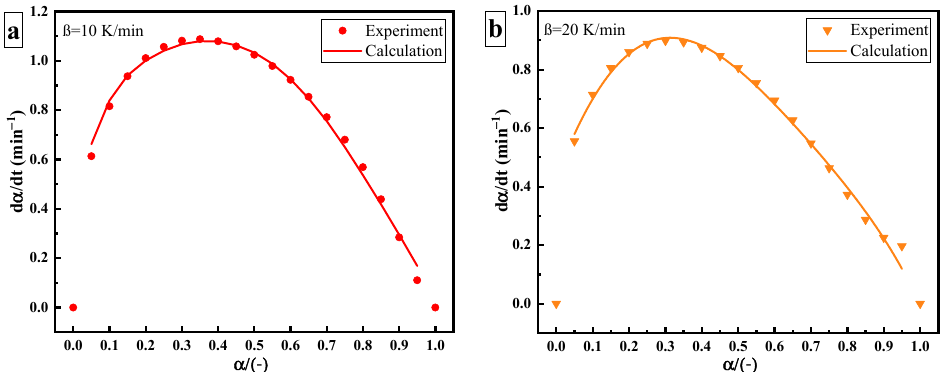
Figure 6. Curing rate–curing degree curves of thermal curing: heating rate of ( a ) 5 K/min; ( b ) 10 K/min; ( c ) 15 K/min; ( d ) 20 K/min.